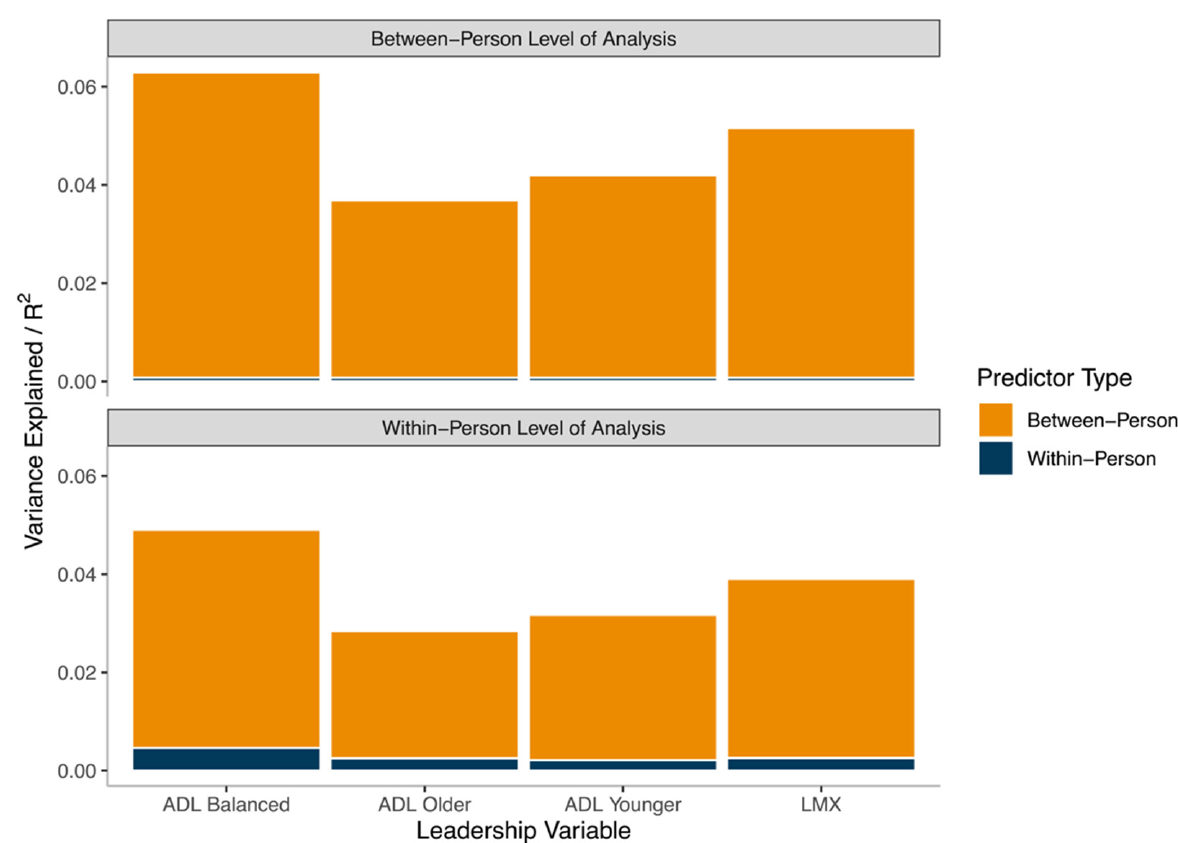
Figure 2. Results of Dominance Analysis. Note: ADL = age-differentiated leadership; LMX = leader-member exchange. Total within-person R 2 = 0.1482; total between-person R 2 = 0.1933. Estimates of R 2 derived using formulae from Snijders and Bosker.